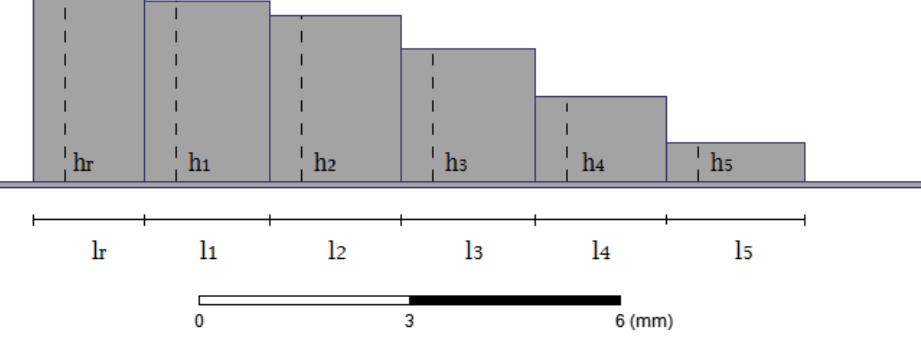
Figure 6. Ridge cascade structure: side view. The first ridge (of size h r , l r ) is the same as in Figure 2, where the coaxial pin is shorted. The remaining ridges make up the Chebyshev impedance transformer, whose size h i , l i , i = 1, ..., 5 are optimized via the PSO